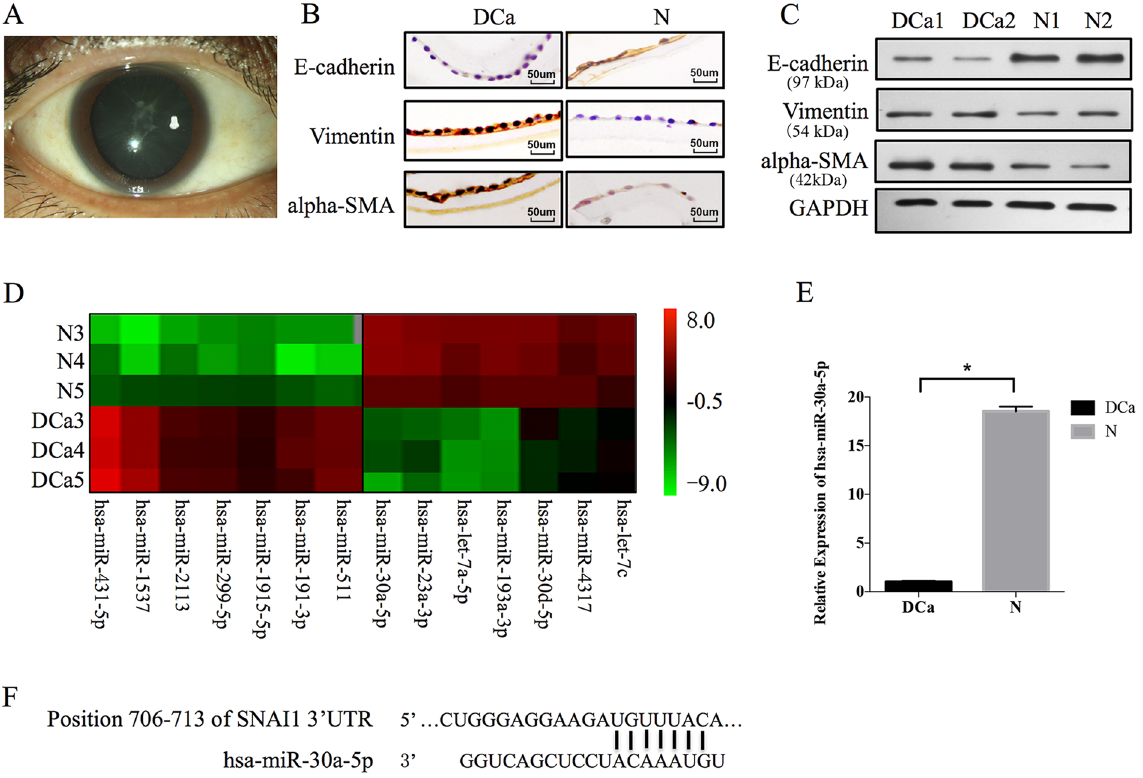
Figure 1. Expression of the epithelial marker (E-cadherin) and EMT markers (vimentin and alpha-SMA) and miRNA profiles in the normal and diabetic cataract lens epithelial cells (LECs). ( A ) Opacity of lens subcapsular tissues in diabetic cataract patients. ( B ) Immunohistochemistry demonstrated a high expression of E-cadherin and a low expression of vimentin and alpha-SMA in normal LECS, and a significantly downregulated expression of E-cadherin and an upregulated expression of vimentin and alpha-SMA in diabetic cataract LECs. ( C ) Western blotting for quantification of the protein expression (top, data from the gels; bottom, normalization to GAPDH). Two normal samples (N1 and N2) and two diabetic cataract samples (DCa1 and DCa2) were included. ( D ) Hierarchical clustering was performed [Rows, miRNA; Column, three normal samples (N3, N4, and N5) and three diabetic cataract samples (Dca3, Dca4, and Dca5)]. A total of 272 miRNAs were identified as having an altered expression more than 2-fold between the diabetic cataract and normal LECs, and 14 regulated miRNAs were depicted in this figure. The red color indicates the high expression, and the green color denotes the low expression. ( E ) qRT-PCR was performed by using the same extracted total RNA for the microarray analysis to validate the microarray data. The relative amount of hsa-miR-30a-5p was normalized to the U6 expression. The relative expression levels of hsa-miR-30a-5p were downregulated significantly in the diabetic cataract LECs (N as control, * P < 0.05). Significant differences are indicated by t-test ( * P < 0.05). ( F ) Position of the miR-30a-5p target sequence in the 3 ′ -UTR of SNAI1